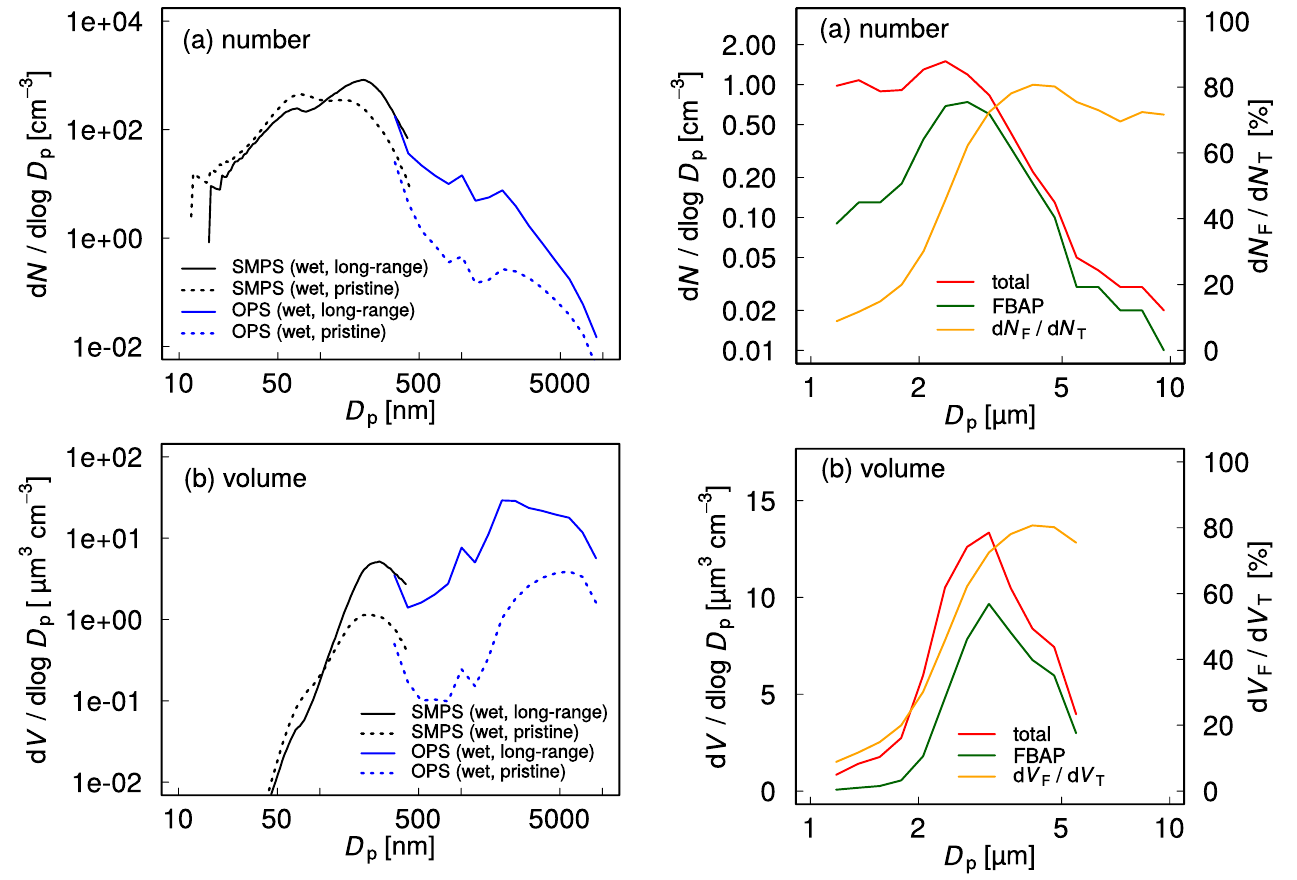
Figure 29. Average number (a) and volume (b) size distributions of the total and fluorescent aerosol particles measured by WIBS. Orange lines refer to the size-resolved fraction of